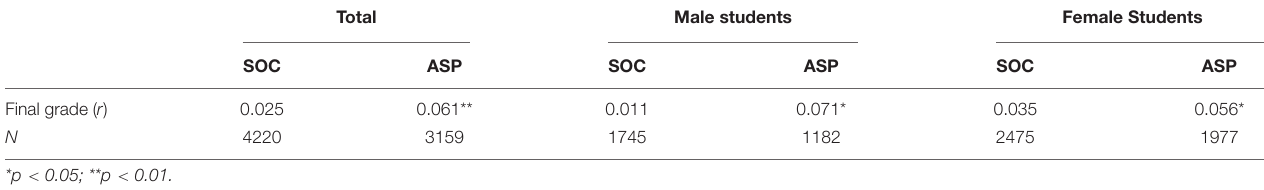
TABLE 3 | Correlations of social congruence (SOC) and aspirational congruence (ASP) with grades for all students (Total) and separation of male and female students.